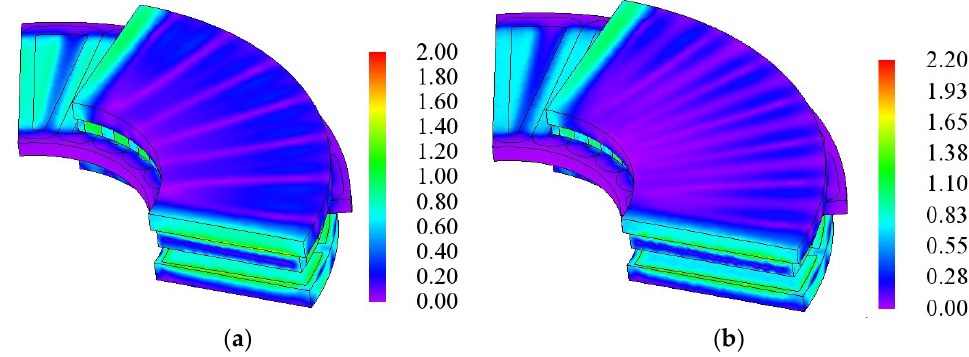
Figure 6. Magnetic density cloud map of the SCM-AFPM motors. ( a ) the initial design of the SCM-